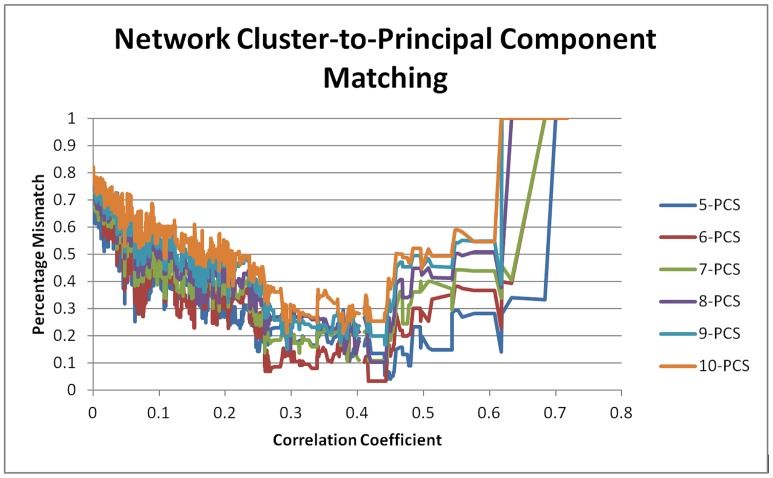
Results of optimizing the network community structure of the CPRS dataset with respect to its principal component structure.Results of the NCS-to-PCS matching procedure for 6 different components structures of the CPRS dataset. X-axis shows the correlation coefficient r as a threshold for significance of a link in the network graph (as r increases to the right, more links are pruned from the network). Y-axis shows dissimilarity (mismatch) scores. Dark blue: 5-PCS, dark red: 6-PCS, green: 7-PCS, purple: 8-PCS, turquoise: 9-PCS, orange: 10-PCS. Mismatch scores collapse at r = 0.27 (p = 1.67E-04), indicating an optimal threshold for the Psychopathology Web and a corresponding six-cluster solution. For details, see text and Tables 1 and 2.